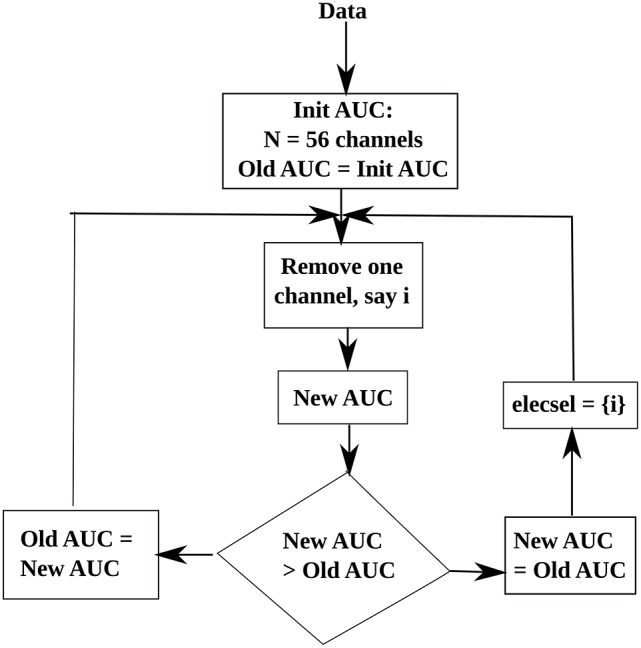
Flowchart of the electrode selection algorithm. Here, elecsel stands for a subset of selected electrodes (or channels).